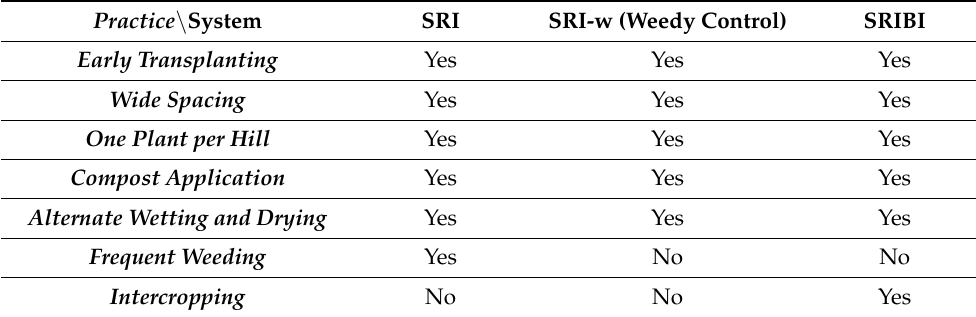
Table 1. A comparison of the different agricultural practices in standard SRI (System of Rice Intensifi- cation) and the two other SRI-based treatments in the current study. Practice \ System SRI SRI-w (Weedy Control) SRIBI Early Transplanting Yes Yes Yes Wide